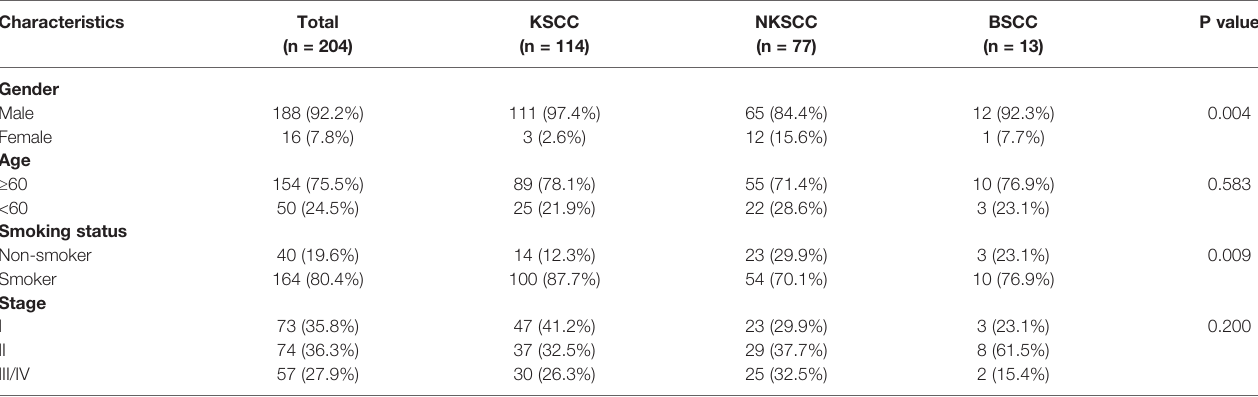
TABLE 1 | Clinical characteristics of 204 LUSC patients with NGS